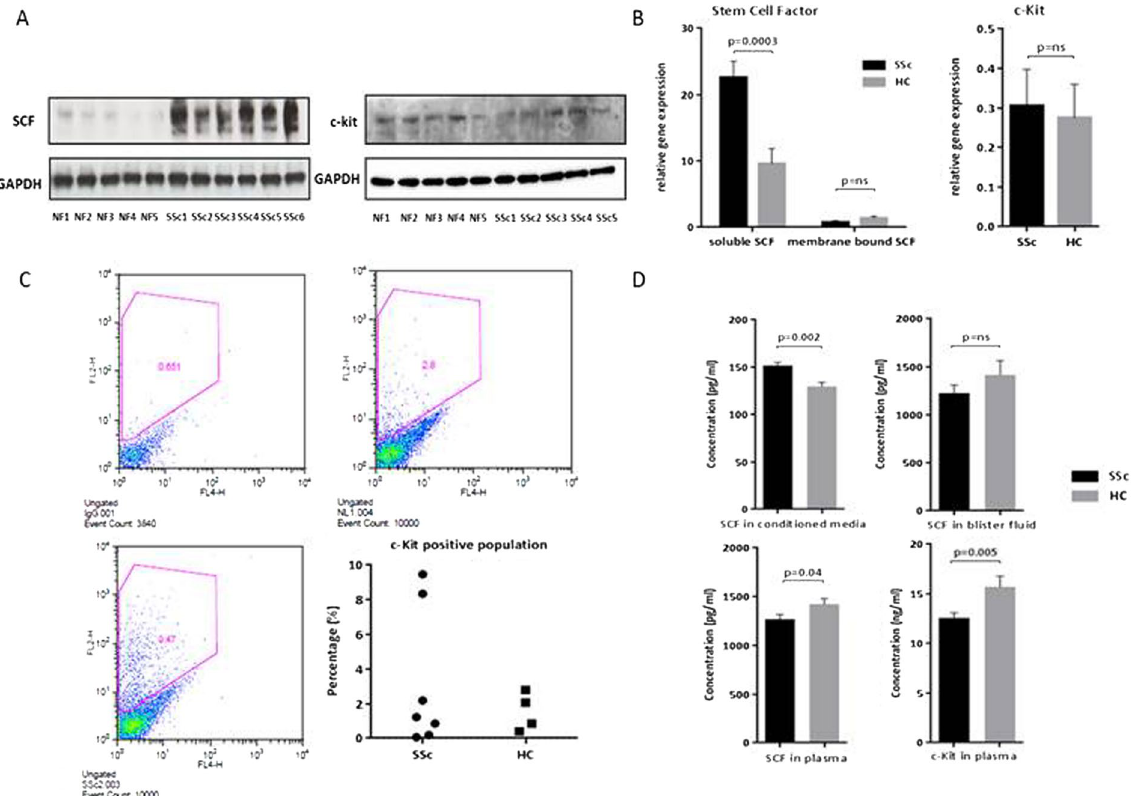
Figure 5. Activity of the SCF/c-Kit pathway in SSc cells and biologic samples. SSc and control lung fibroblasts both n = 5–6, were cultured. Western blot showed that SCF protein was increased in SSc cells compared to the controls. Uncropped films in supplementary data ( A ). qPCR revealed increased full length (soluble) splice variant of SCF in SSc cells, whereas the membrane bound isoform was present at lower and equivalent levels ( B ). C-Kit was expressed at low and similar levels in both SSc and control cells. FACS analysis of SSc and control lung fibroblasts revealed a c-Kit positive subpopulation ( C ). Representative IgG control shown upper left, healthy control lung fibroblasts upper right, SSc lung fibroblasts lower left. A small c-Kit positive sub-population were identified in both SSc samples as well as the control samples (mean for SSc samples 4.21%, mean for control samples 1.86% positive c-Kit cells). In addition, analysis of stem cell factor and c-Kit levels in fibroblast conditioned media, blister fluid and plasma was performed using ELISA. Measurement of SCF revealed a significant difference (p = 0.002) between SSc and HC in conditioned media but no significant difference in dermal blister fluid. Soluble c-Kit however was undetectable in both media and blister fluid (data not shown). In plasma, the healthy control group showed higher levels of both SCF (p = 0.04) and c-Kit (p = 0.005) ( D